Question: Provide a publication-style caption for this figure.
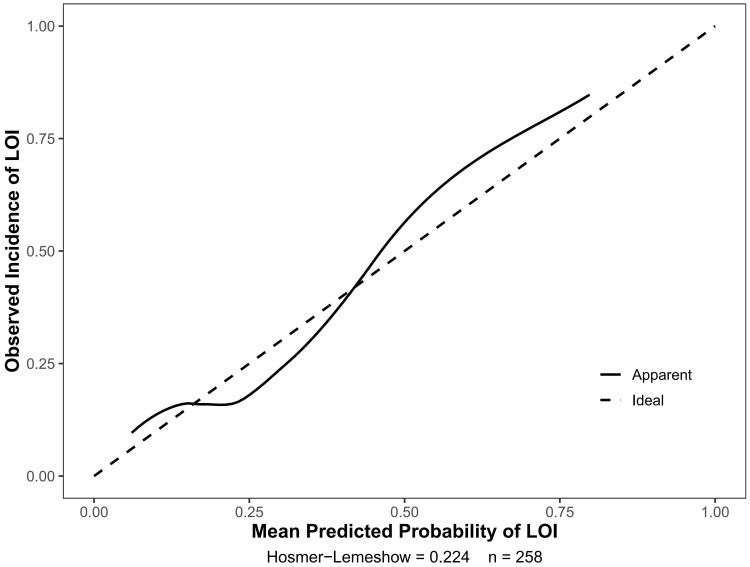
Answer: Calibration curve for the prediction model of postoperative LOI.